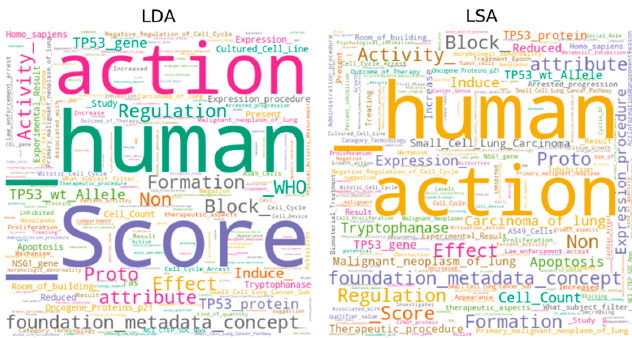
Figure 2. Word cloud of the top-1 topics on the SPS hallmark.